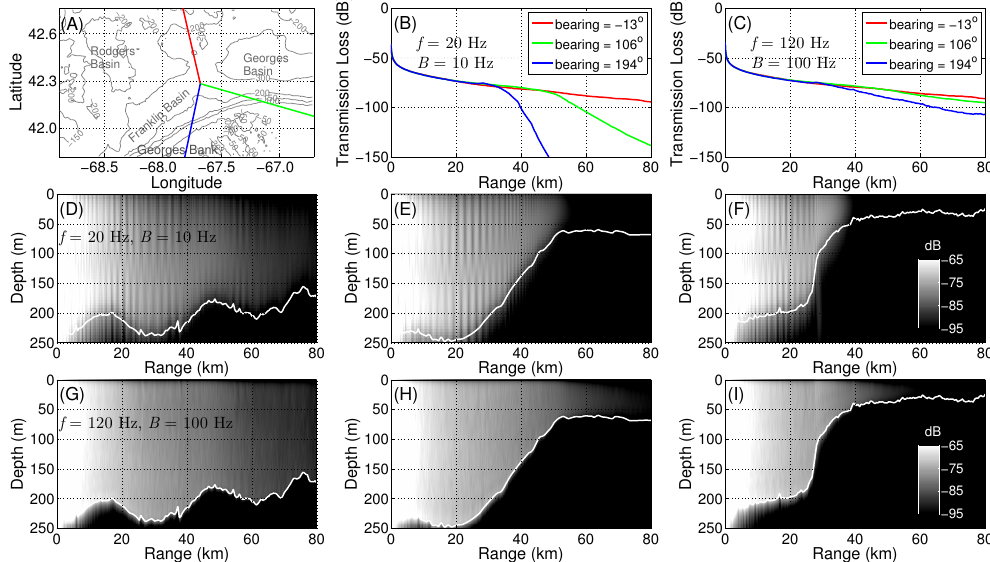
Figure 3. Example of broadband transmission losses calculated by a calibrated [16,41] parabolic equation-based range-dependent acoustic propagation model [42] along three propagation paths with the following directions: − 13 ◦ (roughly northwards crossing Georges Basin), 106 ◦ (roughly eastwards across Georges Bank) and 194 ◦ (roughly southwards across Georges Bank), as shown in ( A ). The transmission losses for two distinct broadband signals centered at 20 Hz and 120 Hz are plotted in ( B , C ), respectively, as a function of propagation range. The modeled broadband waveguide Green functions averaged over 15 Monte Carlo simulations for each signal along the three propagation directions are shown in ( D – F , G – I ), respectively, for the two broadband signals. The Green functions are used to calculate the transmission losses shown in ( B , C ) by averaging over multiple depths from the sea surface to near the sea floor to account for unknown whale